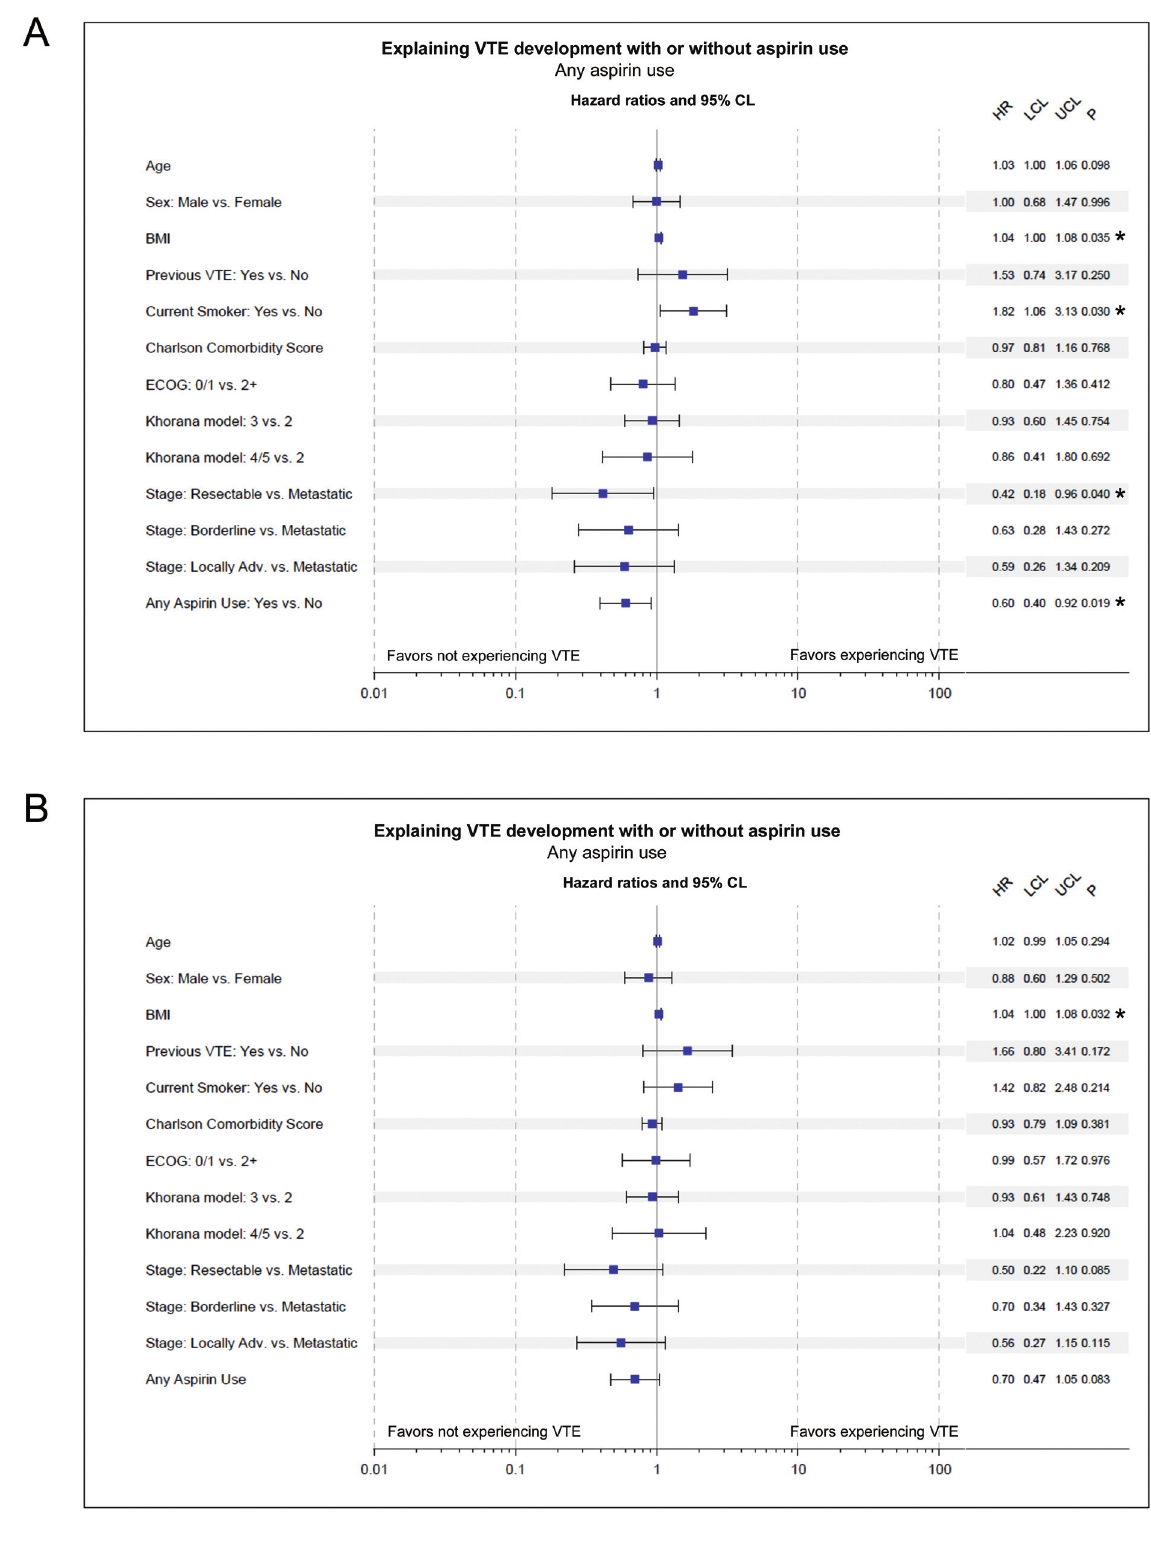
Fig. 3 ( A ) Factors explaining development of VTE after adjustment for important potential confounding covariates, with a Cox proportional hazards model (cause-speci fi c hazard). ( B ) Factors explaining development of VTE using Fine and Gray regression (subdistributional hazard) with death prior to VTE considered a competing event. BMI, body mass index; VTE, venous thromboembolism; ECOG, Eastern Cooperative Oncology Group; PS, performance status; HR, hazard ratio; LCL, lower con fi dence limit; UCL, upper con fi dence limit. (cid:4) indicates p -value < 0.05.